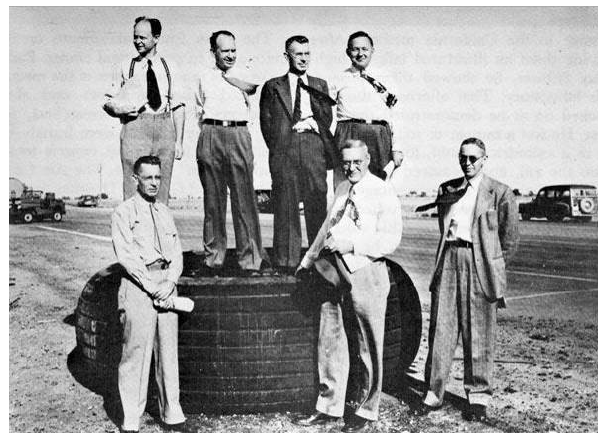
Figure 6. CBR meeting at Stockton, California, Test Track. Front row (left to right): Colonel Henry C. Wolfe, Harold M. Westergaard, and Philip C. Rutledge. In the second row, on the wheel of an XB-19 bomber, (from left to right), Arthur Casagrande, Thomas A. Middle- brooks, James L. Land, and O. James Porter.